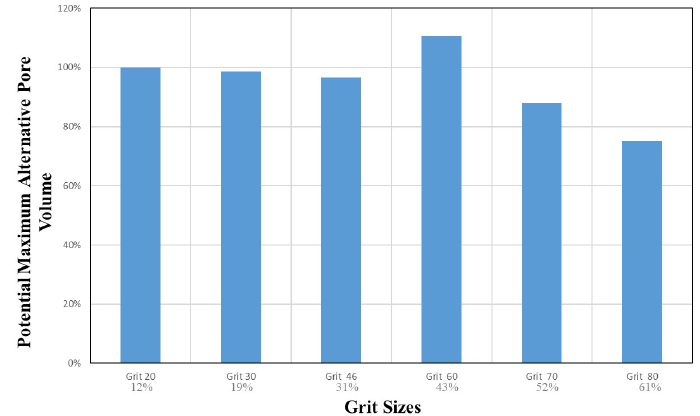
Figure 37. Potential maximum of alternative pore volume dependent on the grit sizes for a fixed dressing depth of 0.1